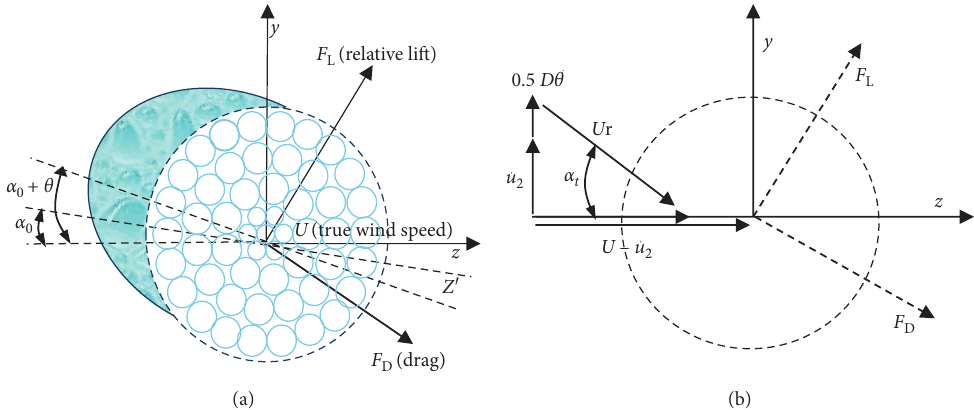
Figure 2: Cross-sectional model of the iced conductor and relative flow. (a) Cross-sectional model of the iced conductor. (b) Relative flow in the quasi-steady